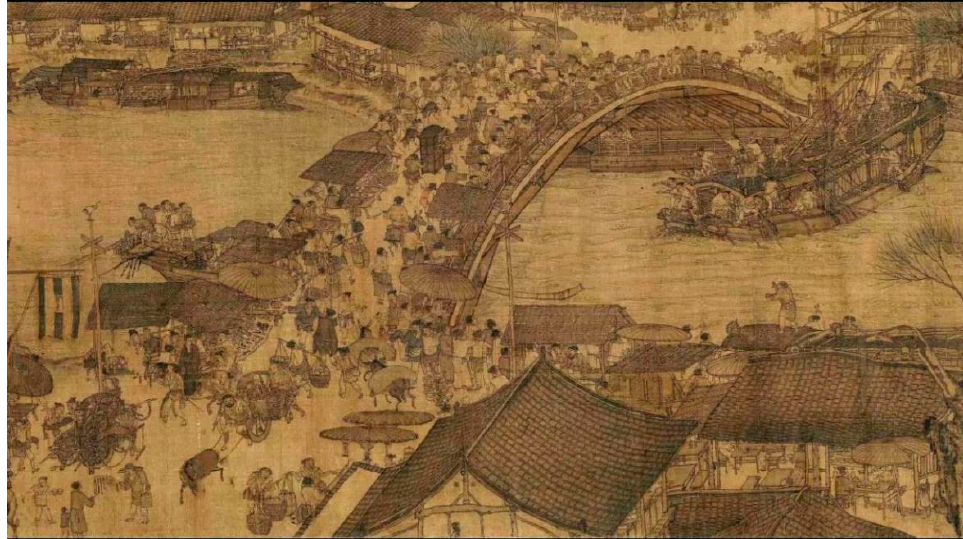
Figure 6. Upriver area during the Qingming